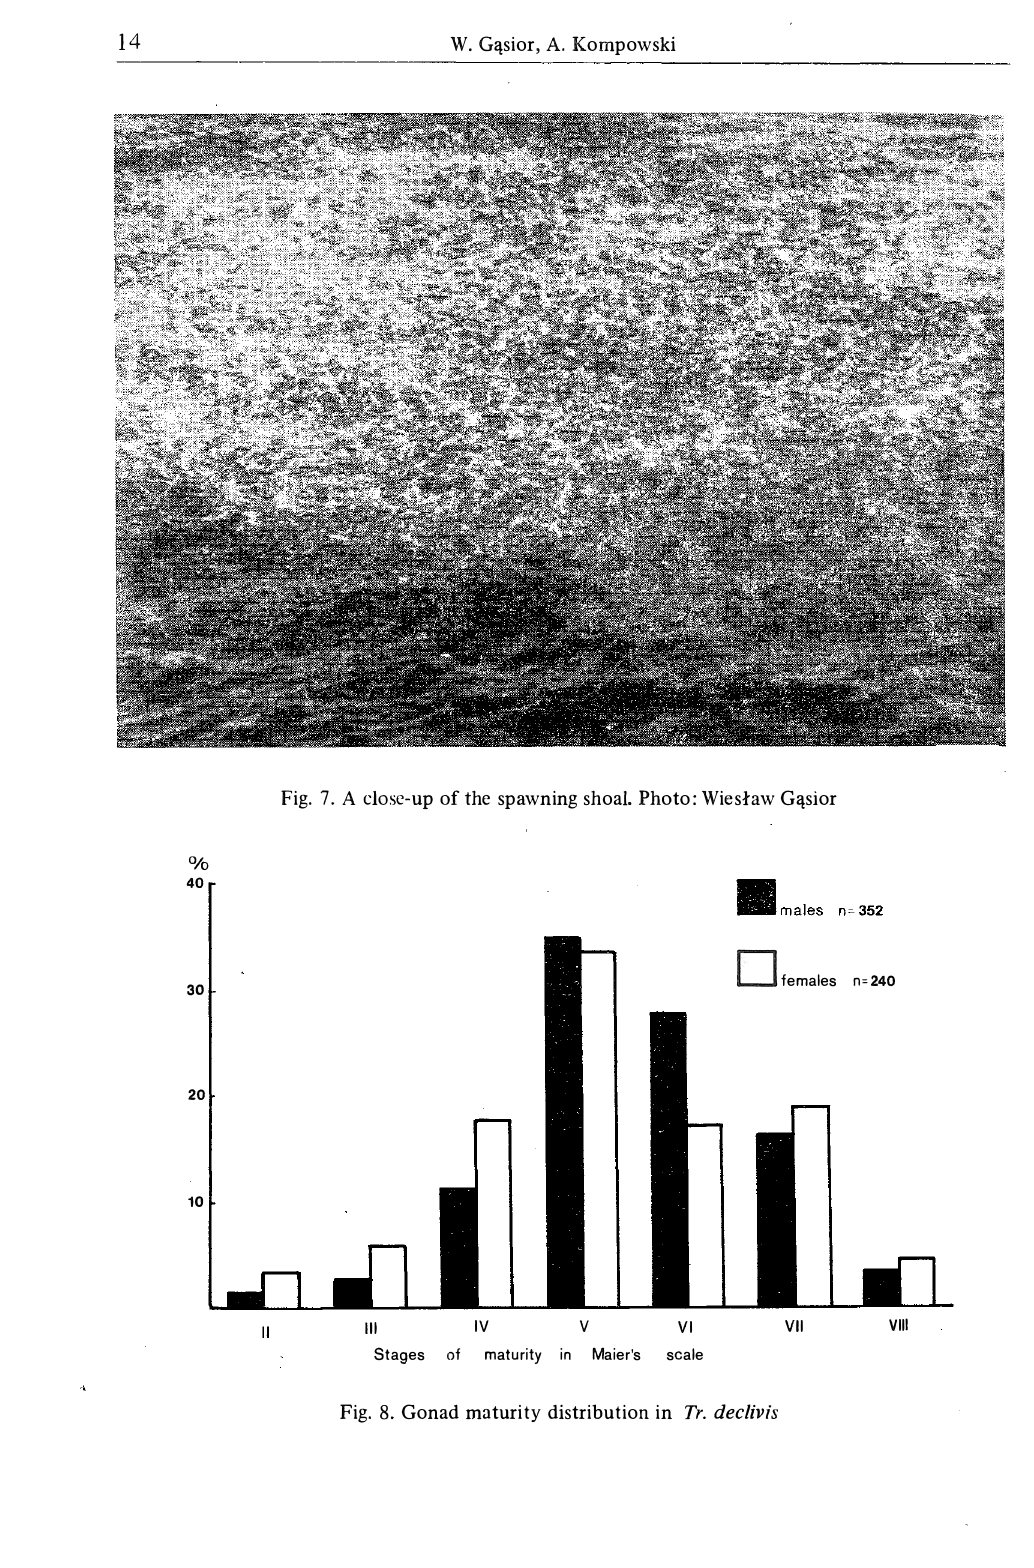
Fig. 8. Gonad maturity distribution in Tr.